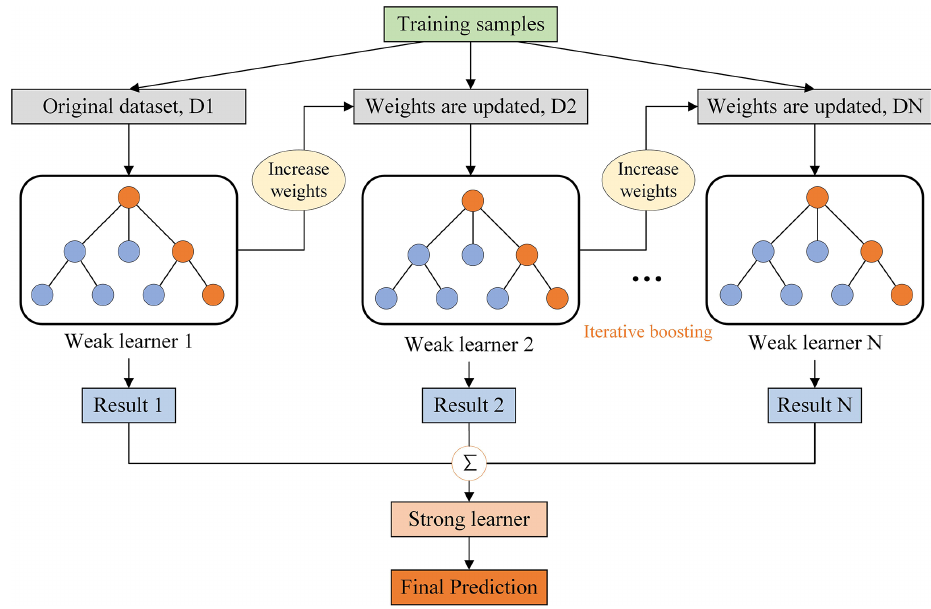
Figure 4. Overview of the GBDT